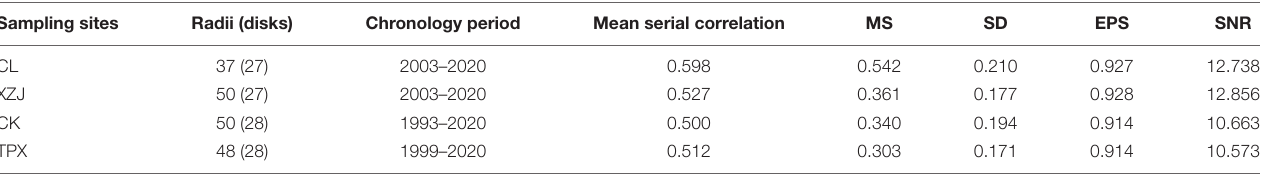
TABLE 2 | The characteristics of ring-width chronologies at each sampling site. Sampling sites Radii (disks)